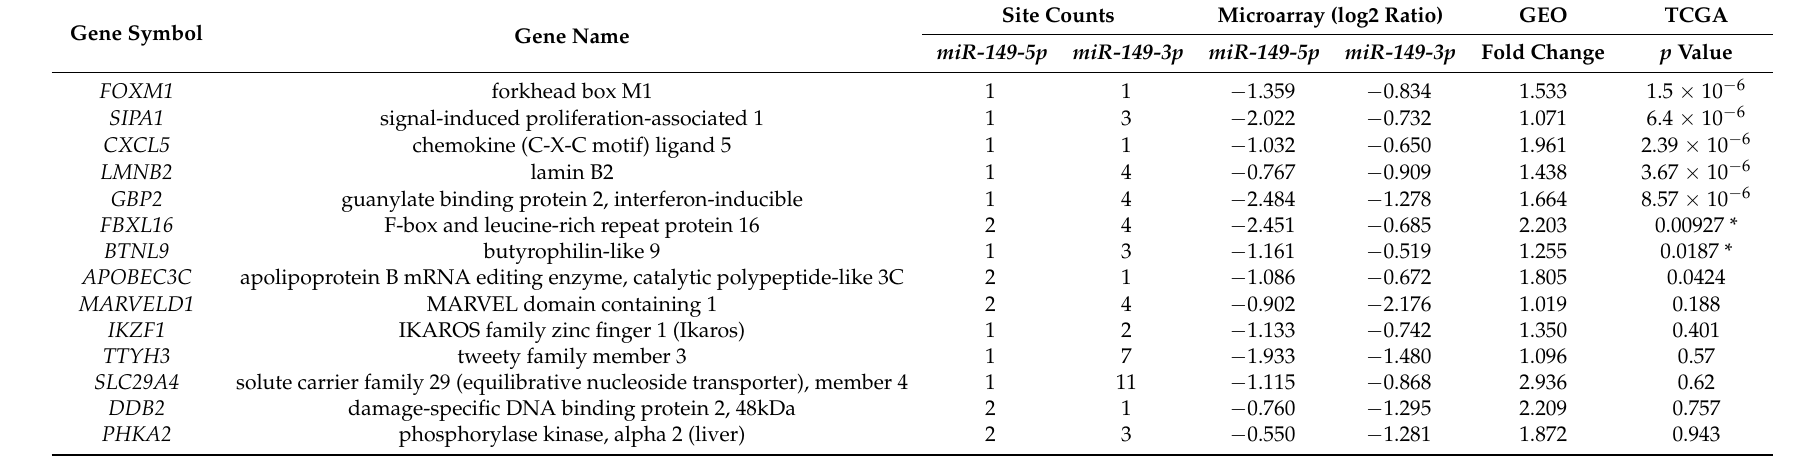
Table 2. Putative target genes regulated by miR-149-5p and miR-149-3p in RCC